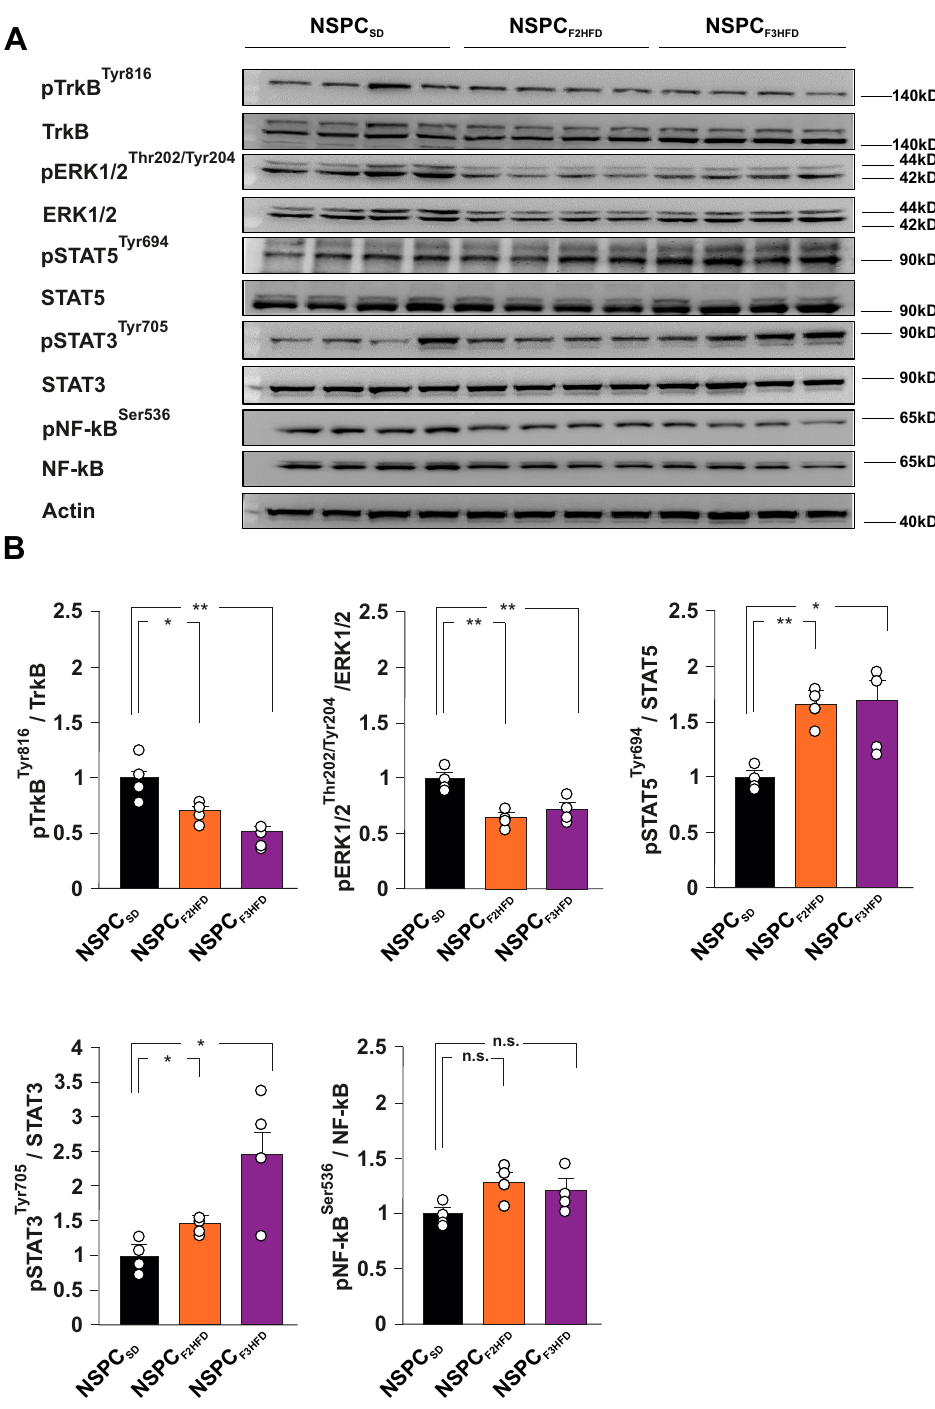
Figure 5. HFD descendants-derived NSPCs showed alterations of TrkB, ERK1/2, and STAT3/5 signal- ing. ( A ) Immunoblots and ( B ) bar graphs showing the levels of both expression and phosphorylation of TrkB, ERK1/2, STAT3, STAT5 and NF- κ B ( n = 4) in NSPC SD , NSPC F2HFD and NSPC F3HFD (statis- tics by one-way ANOVA and Bonferroni post hoc). Data are expressed as mean ± SEM. * p < 0.05; ** p < 0.01; n.s. is not